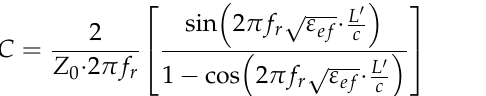
Figure 7. Analytical model for the effect of the human finger (parallel capacitor C ) when touching the resonator. The loop was modeled by a SC transmission line (TL) of characteristic impedance Z 0 where a capacitor C was considered at the center of the TL.